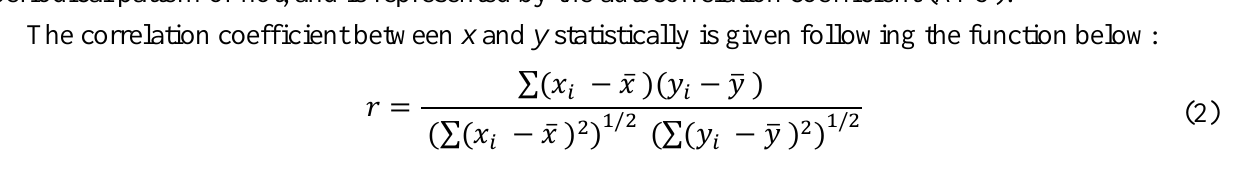
In Figure 4(a) note: green = vegetation, light magenta = bareland/fallow, darker magenta(red) = built up, dark blue = inundated paddy rice/fishpond, black = water body(sea)shadow, white =